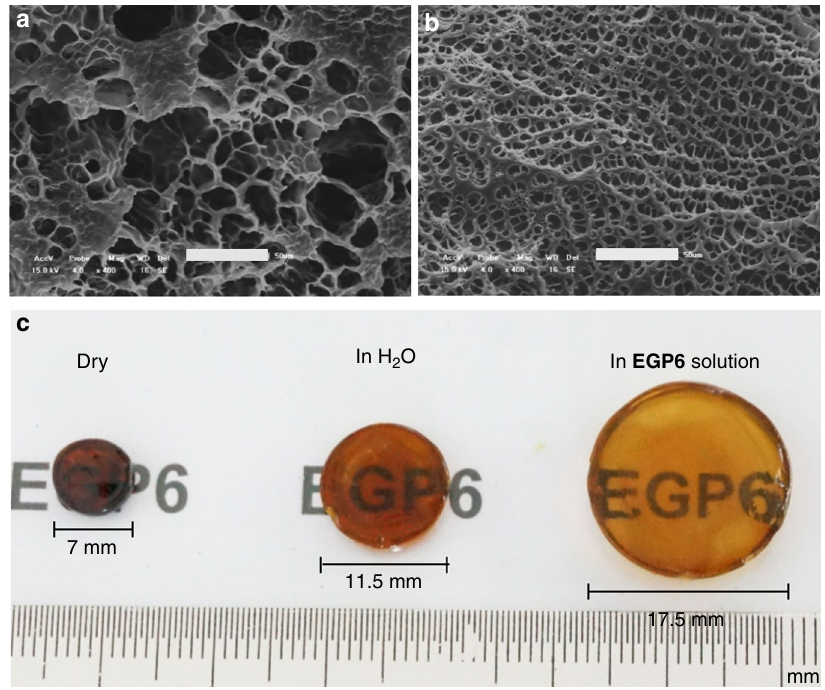
Fig. 3 SEM micrographs and photographs of hydrogels. SEM micrographs of freeze-dried Fc-gel immersed in a pure water and b EGP6 aqueous solution (15 mM); Scale bars are 50 µ m. c the corresponding photographs of Fc-gel under different conditions